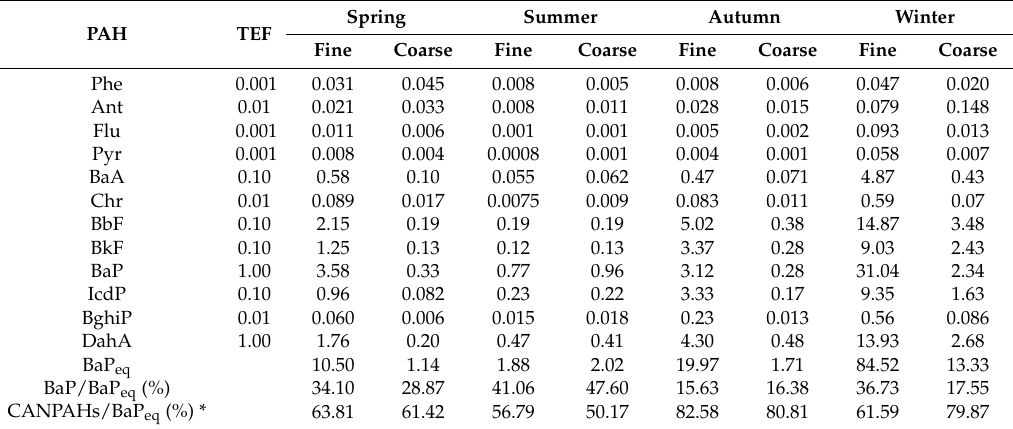
Table 2. BaP eq concentrations (ng m − 3 ) for fine and coarse particles in different seasons. Spring Summer Autumn Winter PAH TEF Fine Coarse Fine Coarse Fine Coarse Fine Coarse Phe